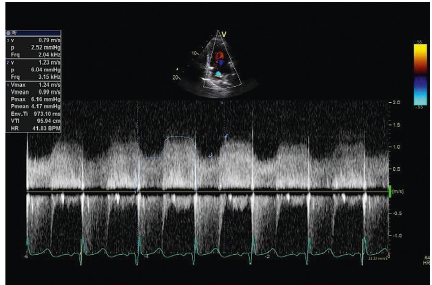
Figure 2: Continuous wave Doppler signal across the opening of the cor triatriatum membrane showing mildly accelerated flow throughout the cardiac cycle. The peak diastolic gradient was measured at